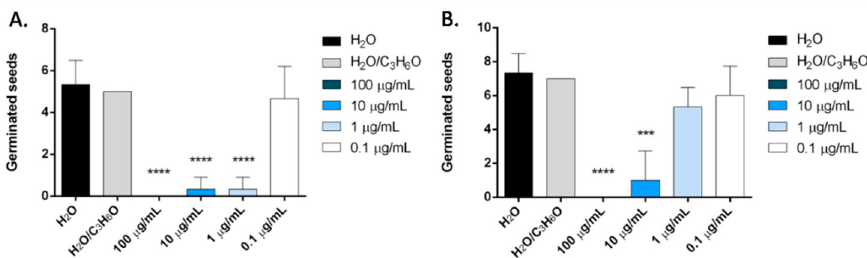
Figure 9. Phytotoxic activity of carvacrol against radical elongation of R. sativum ( A ), S. lycopersicum ( B) , L. sativa ( C) , L. sativum ( D ). Results are expressed as the mean of three experiments standard deviation. * p < 0.05, ** p < 0.01, *** p < 0.001 compared to control (ANOVA followed by Dunnett’s multiple comparison test).